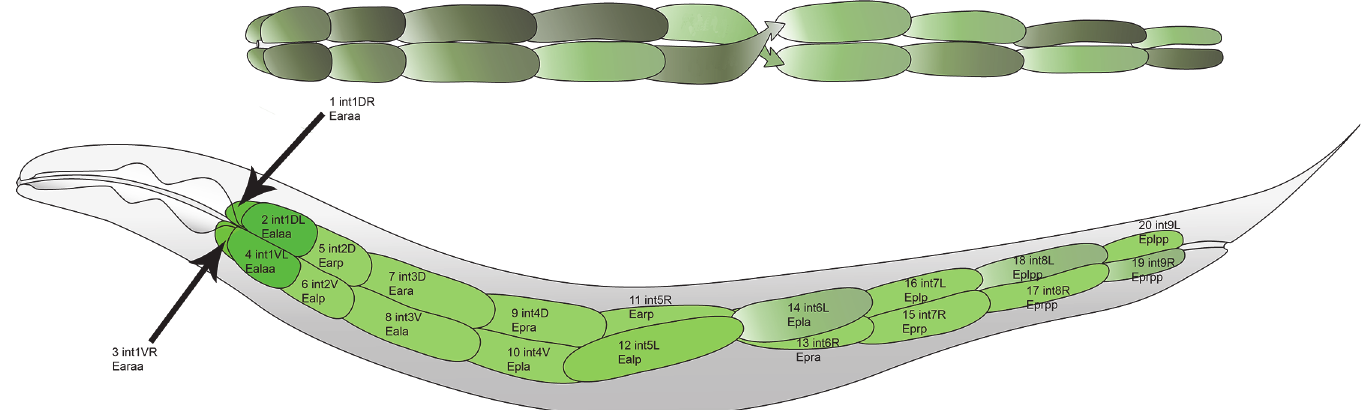
Fig 2. Layout of cells comprising the adult C . elegans intestine. Top panel shows the location of the left-handed helical half twist. Bottom panel shows the intestine within an animal. Anteriormost ring is comprised of four cells, remaining rings are made up of two cells, all arranged around a hollow core with the half twist between ring V and ring VI. Cells are identified by proper intestine cell name (e.g., int5L), progenitor cell (lineage, e.g., Ealp), and number (e.g., #12). Cells in L lineage are even numbers and cells in R lineage are odd numbers. We refer to these cells by their numbers in the x axis of Fig 4. A more anatomically detailed cartoon with corresponding microscopic images that are also anatomically detailed is available as S1 Fig; identification of the nuclei in the cells in the twist in microscopic images is also shown in S6 Fig.